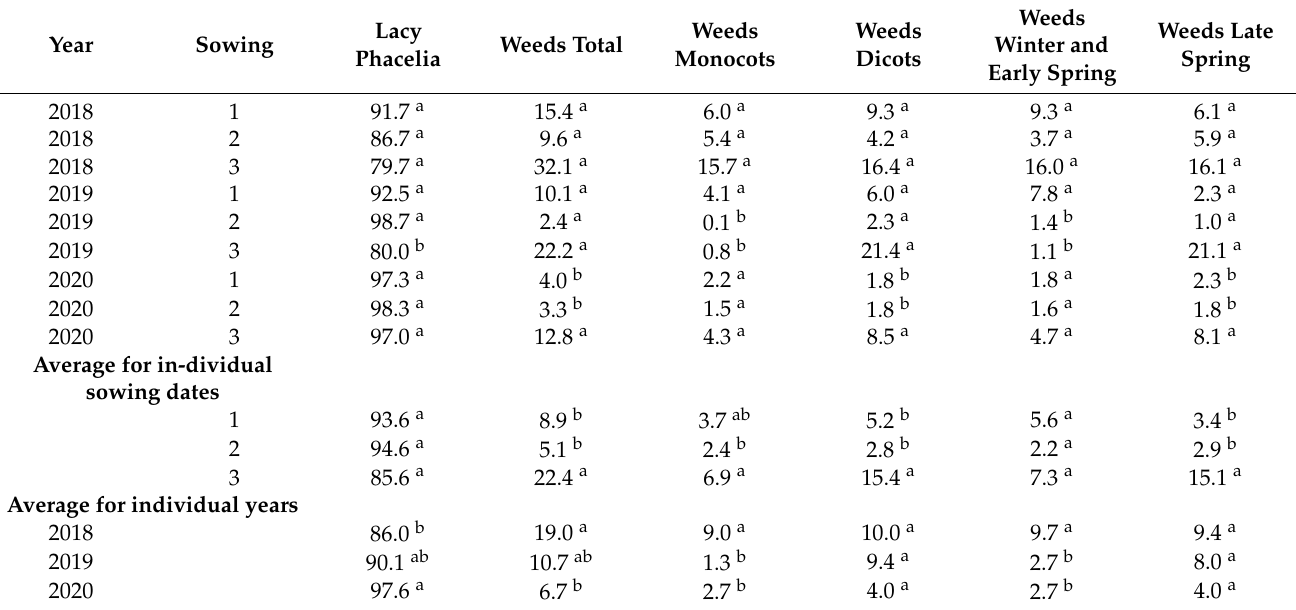
Table 3. Effect of sowing date on coverage of plants on the plot.